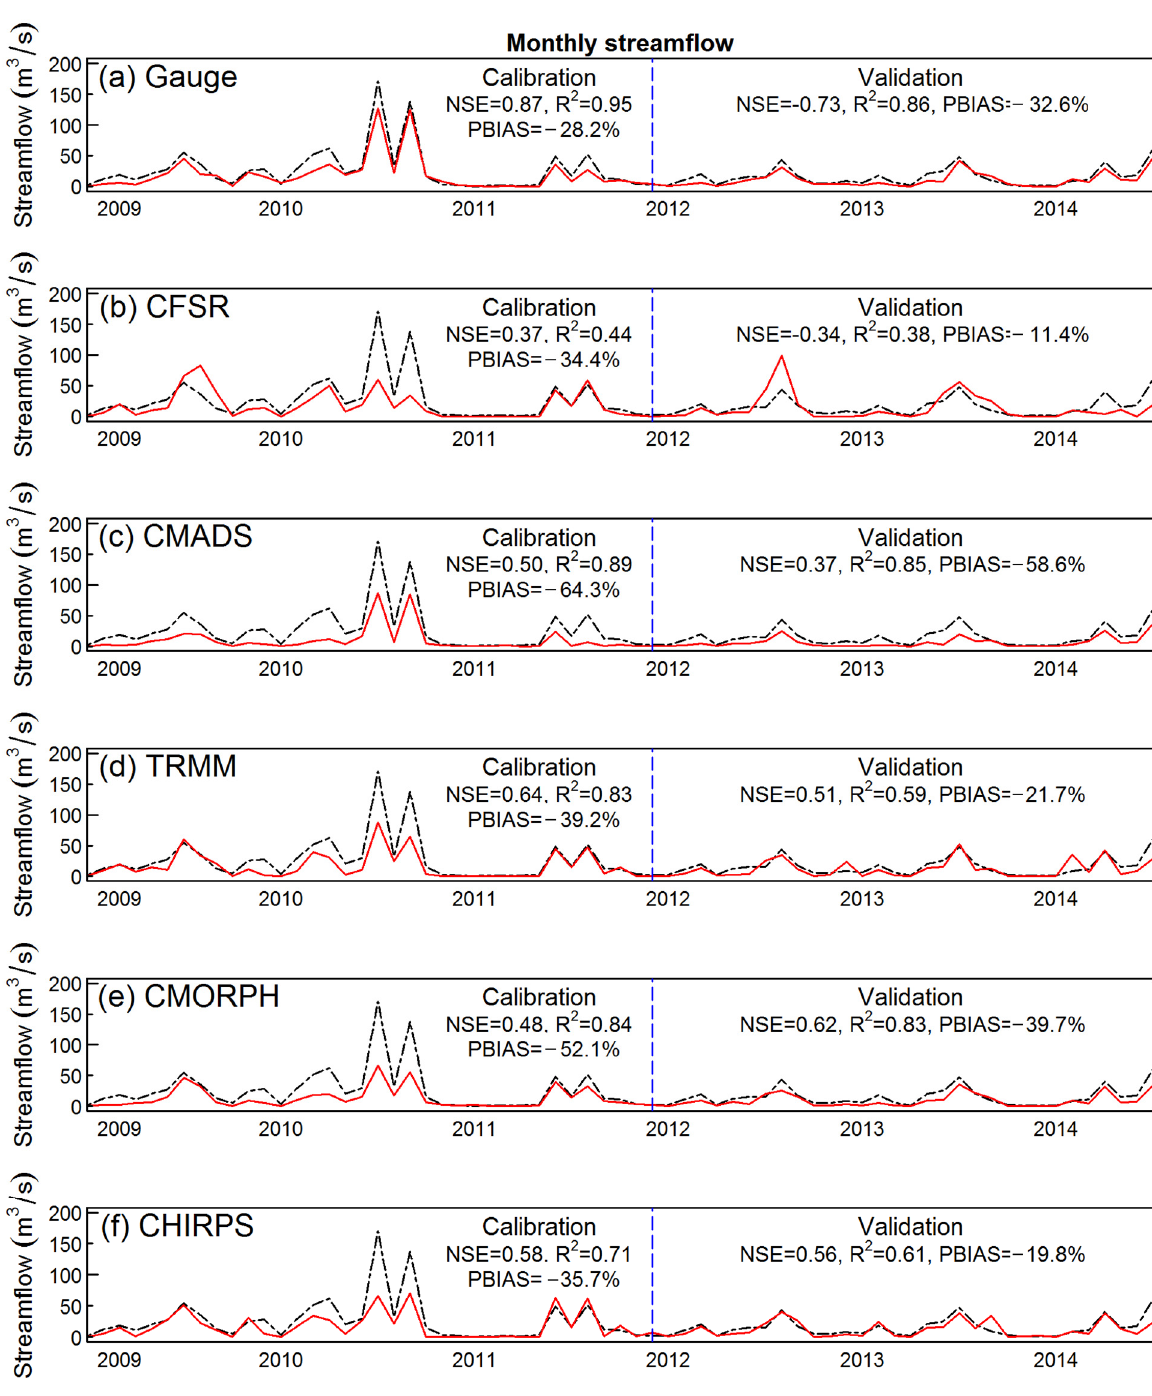
Figure 8. Comparison of monthly measured (black line) and simulated (red line) streamflow from models using the CFSR meteorological (excluding precipitation) datasets and six different precipitation datasets for the period 2009–2014, including ( a ) Gauge, ( b ) CFSR, ( c ) CMADS, ( d ) TRMM, ( e ) CMORPH, and ( f ) CHIRPS.